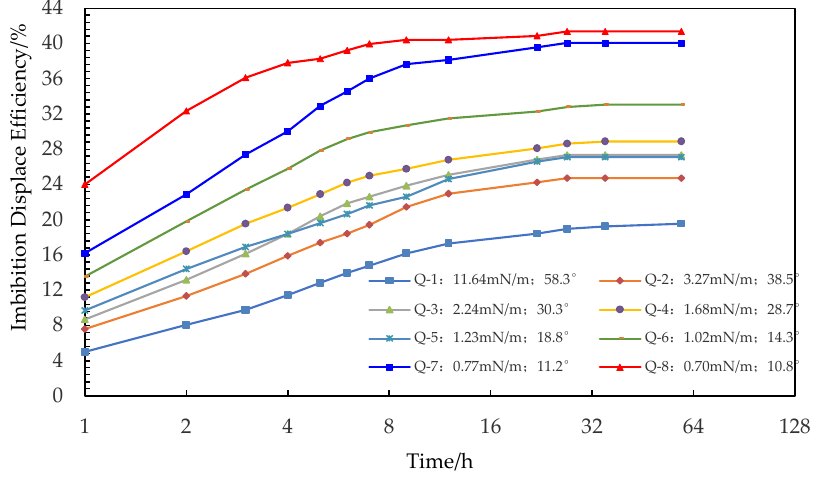
Figure 6. Displacement efficiency curve of imbibition for investigating the interface characteristics.